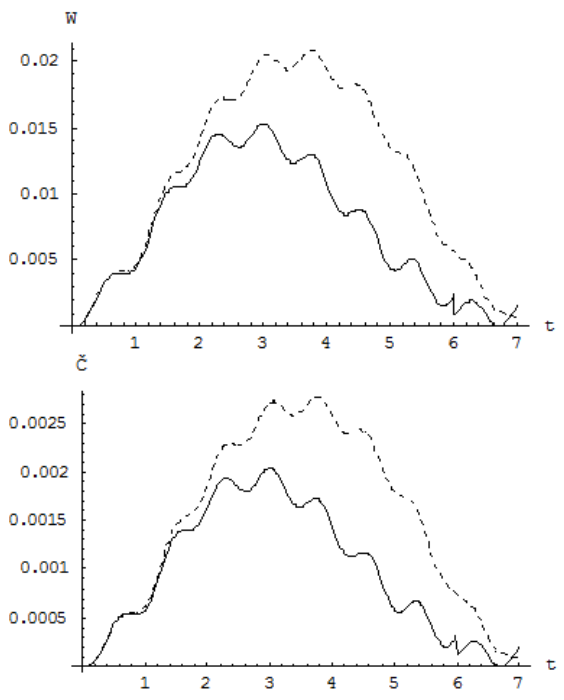
Figure 33: The vertical-torsional motion of the middle of the bridge for υ = 10 m/s and for damped vehicle ( __ ) , simple vehicle ( - - - ).